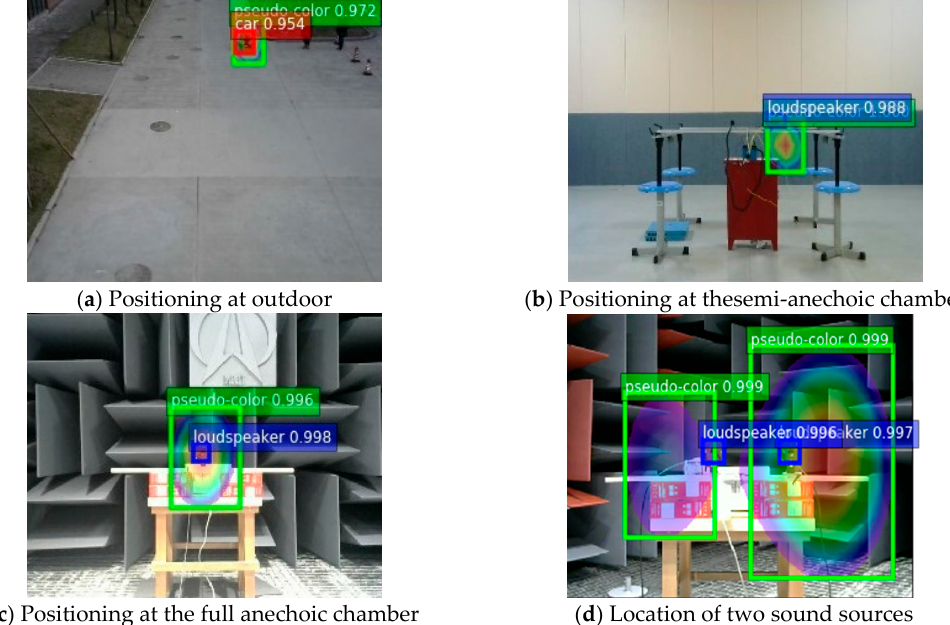
Figure 12. YOLOv4 algorithm positioning results.